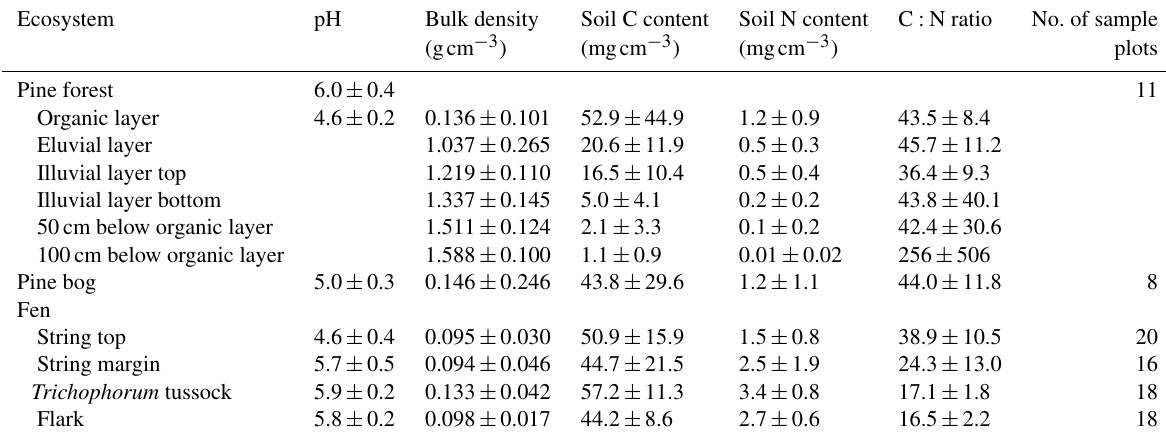
Table A4. Soil and peat properties (mean ± standard deviation) for pine forest, pine bog, and fen ecosystems. Except for the pine forest organic layer, pH was always measured at 30cm depth. In pine bog and fen ecosystems, bulk density, C and N content, and C : N ratio are the mean of 0–5 and 15–20cm peat